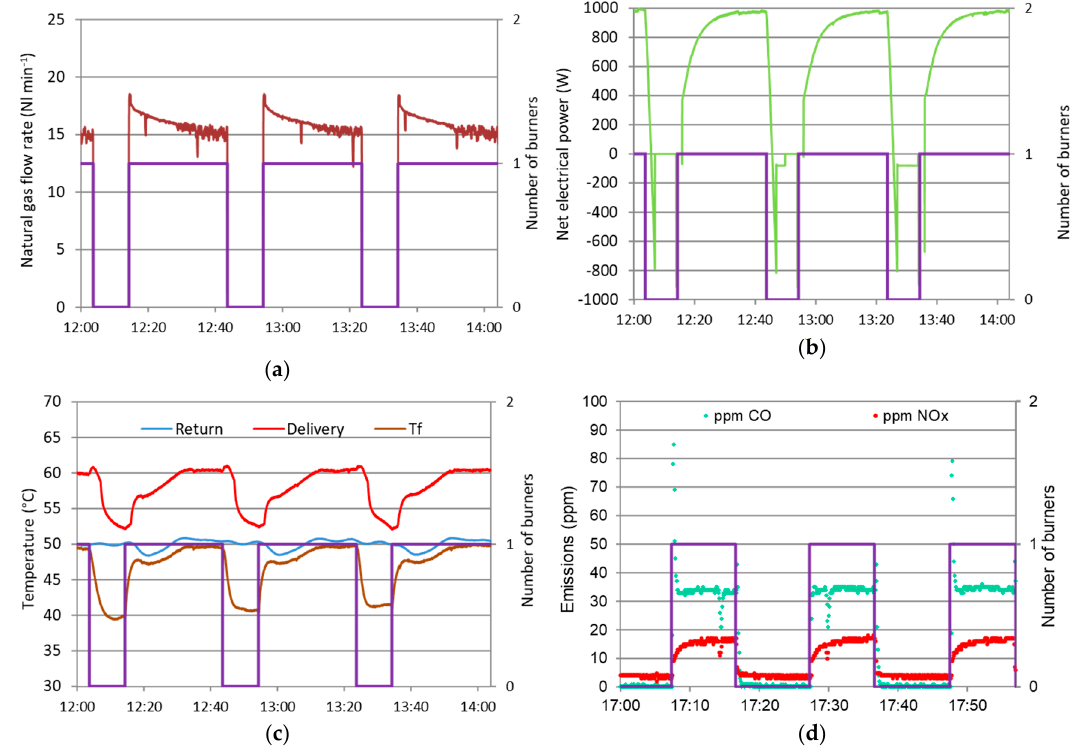
Figure 2. Experimental results of the test on the on–off cycling of the main burner (violet lines show the main burner): ( a ) Natural gas flow rate (Nl/min); ( b ) net electric power (W) (positive is produced, negative consumed); ( c ) temperatures ( ◦ C) of water return (blue line), water delivery (red line), and exhaust (brown line); ( d ) emissions of CO and NO x , referred to 6% O 2 volume dry conditions. Table 2. Experimental results of the Stirling unit performances at steady state operation as well as integrated over the test duration under on–off cycling of the main burner. In the tests, the water inlet temperature is controlled at 50 ◦ C and mass flow rate at 0.194 kg/s, which is the nominal value. LHV and HHV stand for lower/higher heating value. Operation